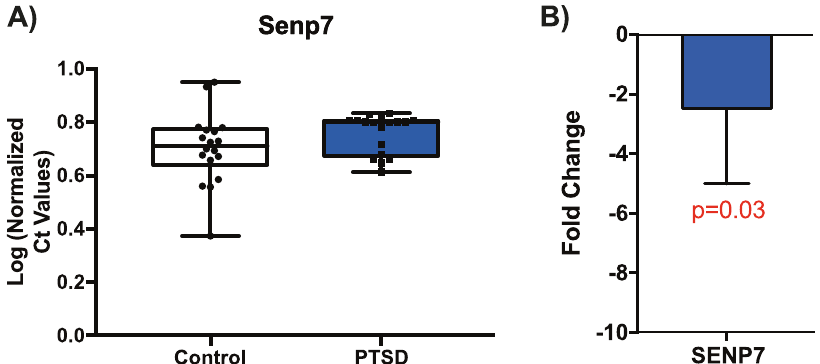
Fig. 3 Postmortem Brain PTSD Findings in Medial Orbitofrontal Cortex. Based on the signi fi cant observed association and then the replication of the SENP (cg09657378) association in the VACS cohort, we examined gene expression in postmortem brain tissue from medial orbitofrontal cortex (Broadmann 11) in PTSD cases and controls. A Box plots of normalized Ct values for SENP7 in controls (white), and PTSD (blue) individuals. B Log 2-fold change of SENP7 in human mOFC ( p < 0.03, n = 35). Error bars indicate ±